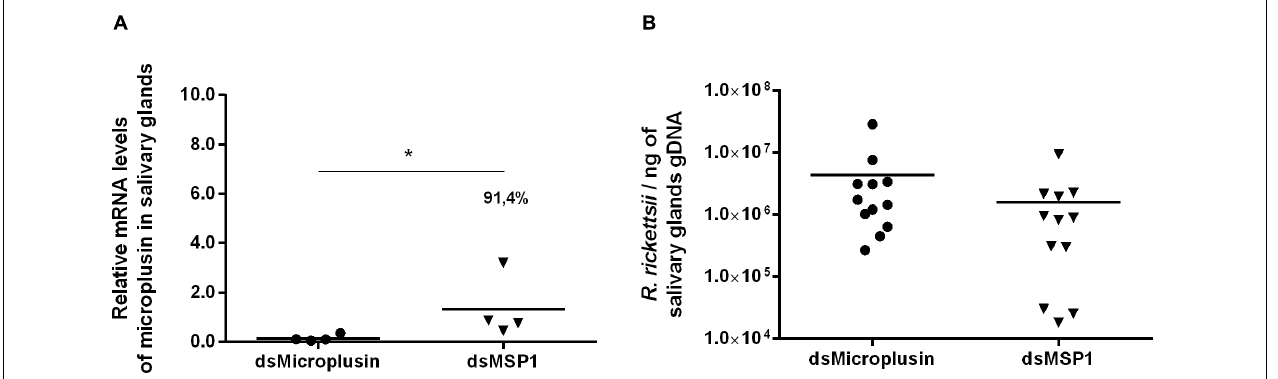
FIGURE 5 | Relative expression of microplusin and rickettsial load in ticks used to evaluate the effects of gene-knockdown on R. rickettsii transmission to rabbits. Specific dsRNA for either microplusin (dsMicroplusin) or MSP1 (dsMSP1; control) were injected into the hemocoel of R. rickettsii -infected ticks. After 24 h, ticks were fed on non-infected rabbits for 5 days. The relative expression of microplusin (A) and the rickettsial load (B) in SG of ticks injected with dsMicroplusin in relation to the control were assessed by RT-qPCR and by qPCR, respectively ( ∗ p < 0.05; Mann–Whitney test). TABLE 2 | Effect of RNAi-mediated silencing of microplusin in R. rickettsii transmission to rabbits. Tick group Rabbit Fever ( > 40 ◦ C) Skin biopsy Death IFA positive in qPCR dsMicroplusin 1 On days 7–8th 1.33 × 10 2 On day 11th NA 2 On days 7–10th − − + dsMSP1 3 On days 7–12th − − + 4 On days 8–9th 3.18 × 10 2 On day 13th